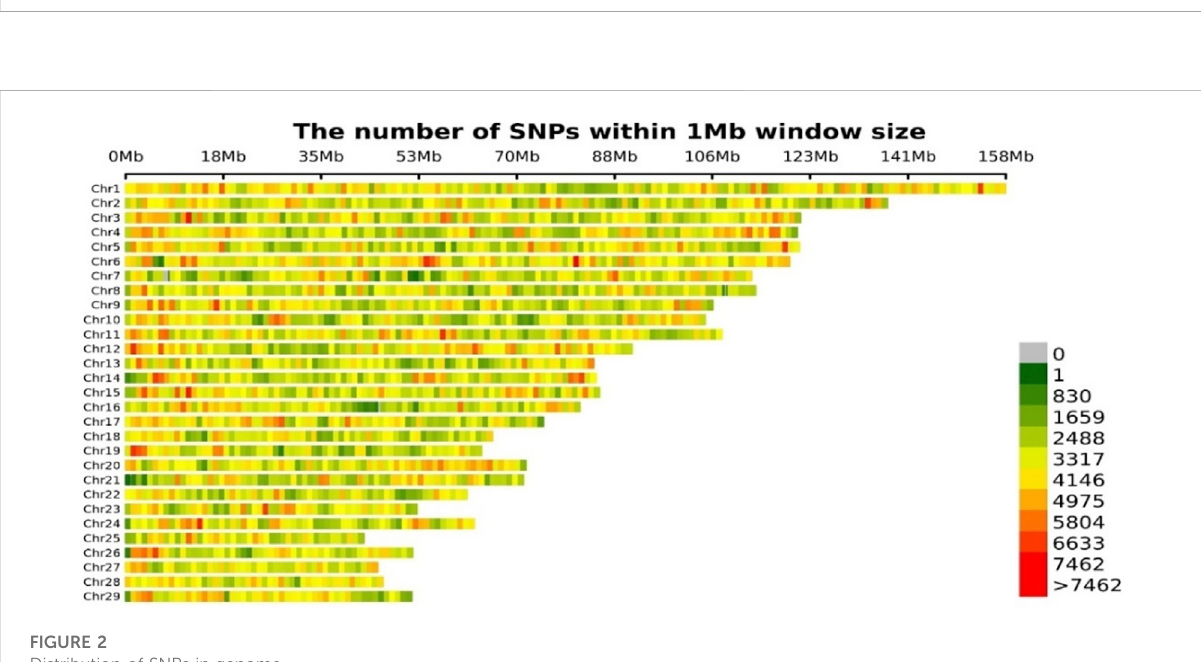
FIGURE 2 Distribution of SNPs in